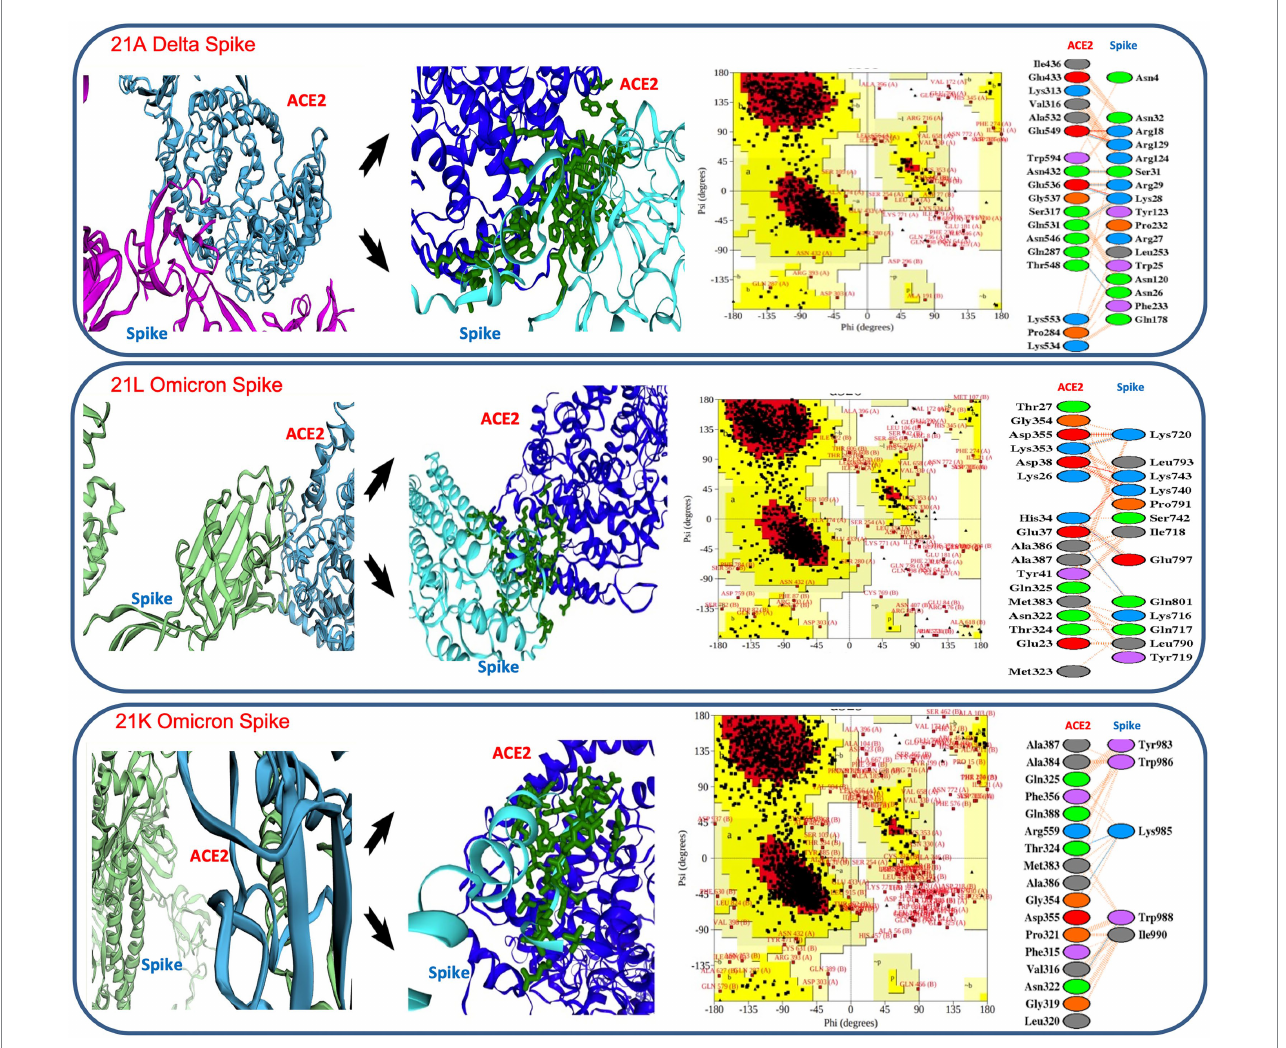
FIGURE 6 Details of in silico docking of SARS-CoV-2 Spike protein with host ACE2 receptor (leftmost across all three panels), intrinsic view of docking area (middle of all three panels), Ramachandran plotting indicating the stability of the docked complex (third block across all three panels), details of the amino acids involved in docking (rightmost across all three panels). It shows 21 K Omicron Spike fused with ACE2 has the lowest stability as the major amino acids fall in the disallowed or restricted